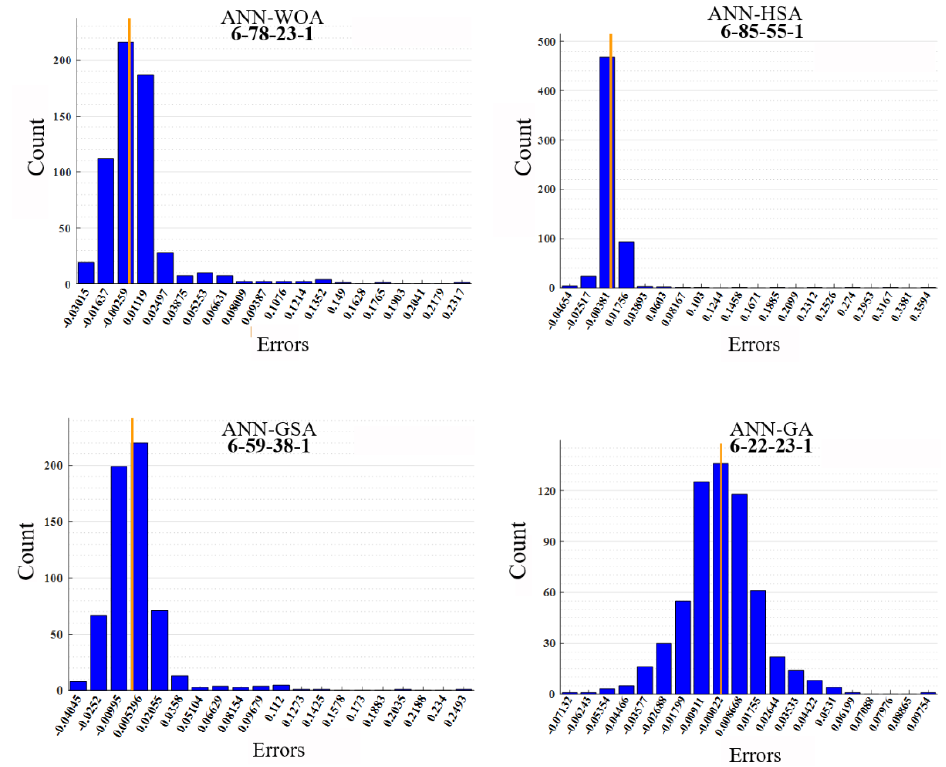
Figure 25. Histograms of the error distributions of predictions using ANN-WOA, ANN-HAS, ANN- GSA, and ANN-GA neural network models.